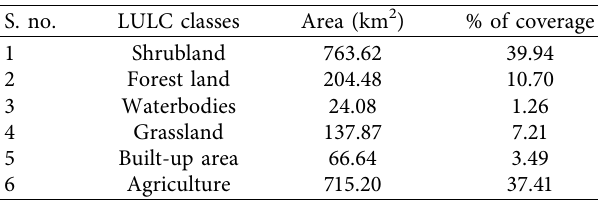
Table 3: Types of land use and land cover in the middle Awata watershed (2018).